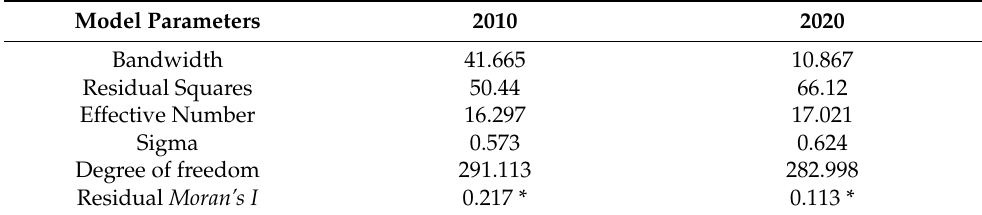
Table 2. SCA-GWR model parameter estimation and test results.